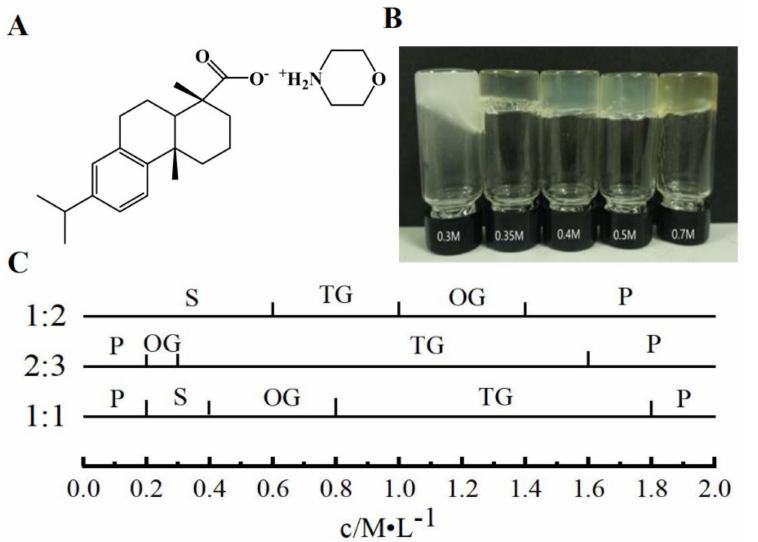
Figure 1. ( A ) Molecular structure of gelator; ( B ) appearance of hydrogels of different concentrations; ( C ) Phase diagrams for different molar ratios of dehydroabietic acid to morpholine. Key: P, precipitate; S, solution; OG, opaque gel; TG, transparent gel.